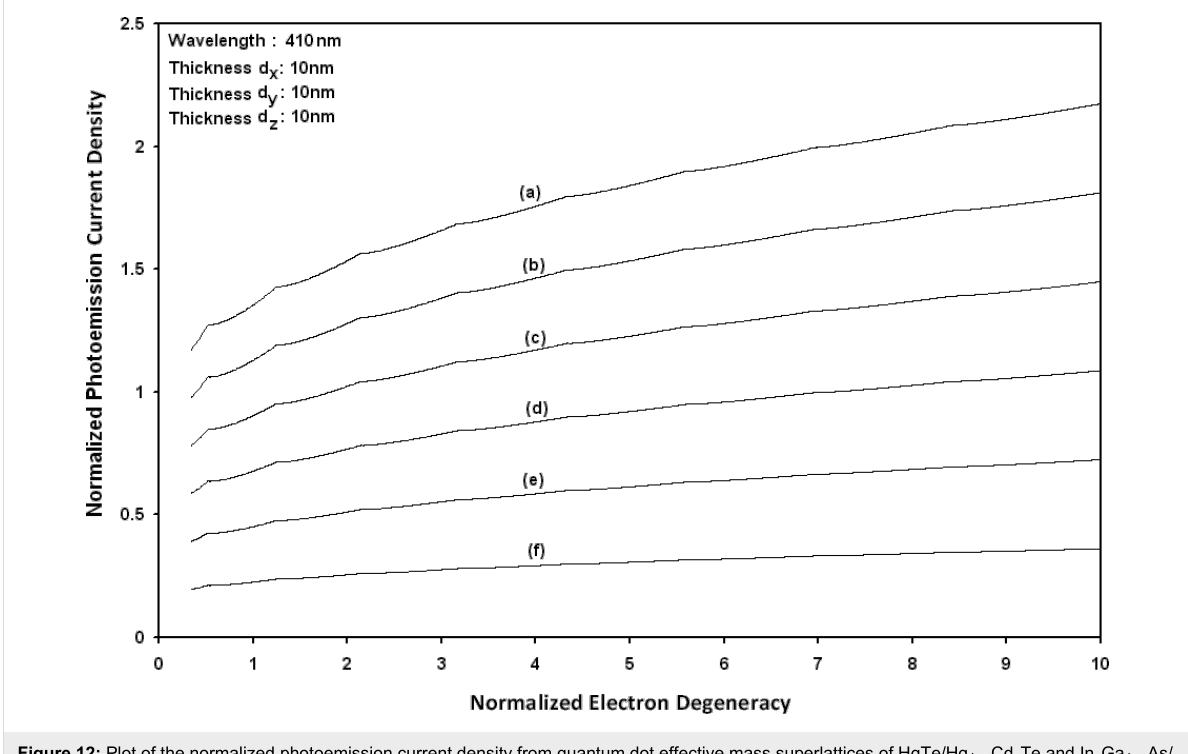
Figure 12: Plot of the normalized photoemission current density from quantum dot effective mass superlattices of HgTe/Hg 1 − x Cd x Te and In x Ga 1 − x As/ InP as a function of normalized electron degeneracy for all cases of Figure 11.